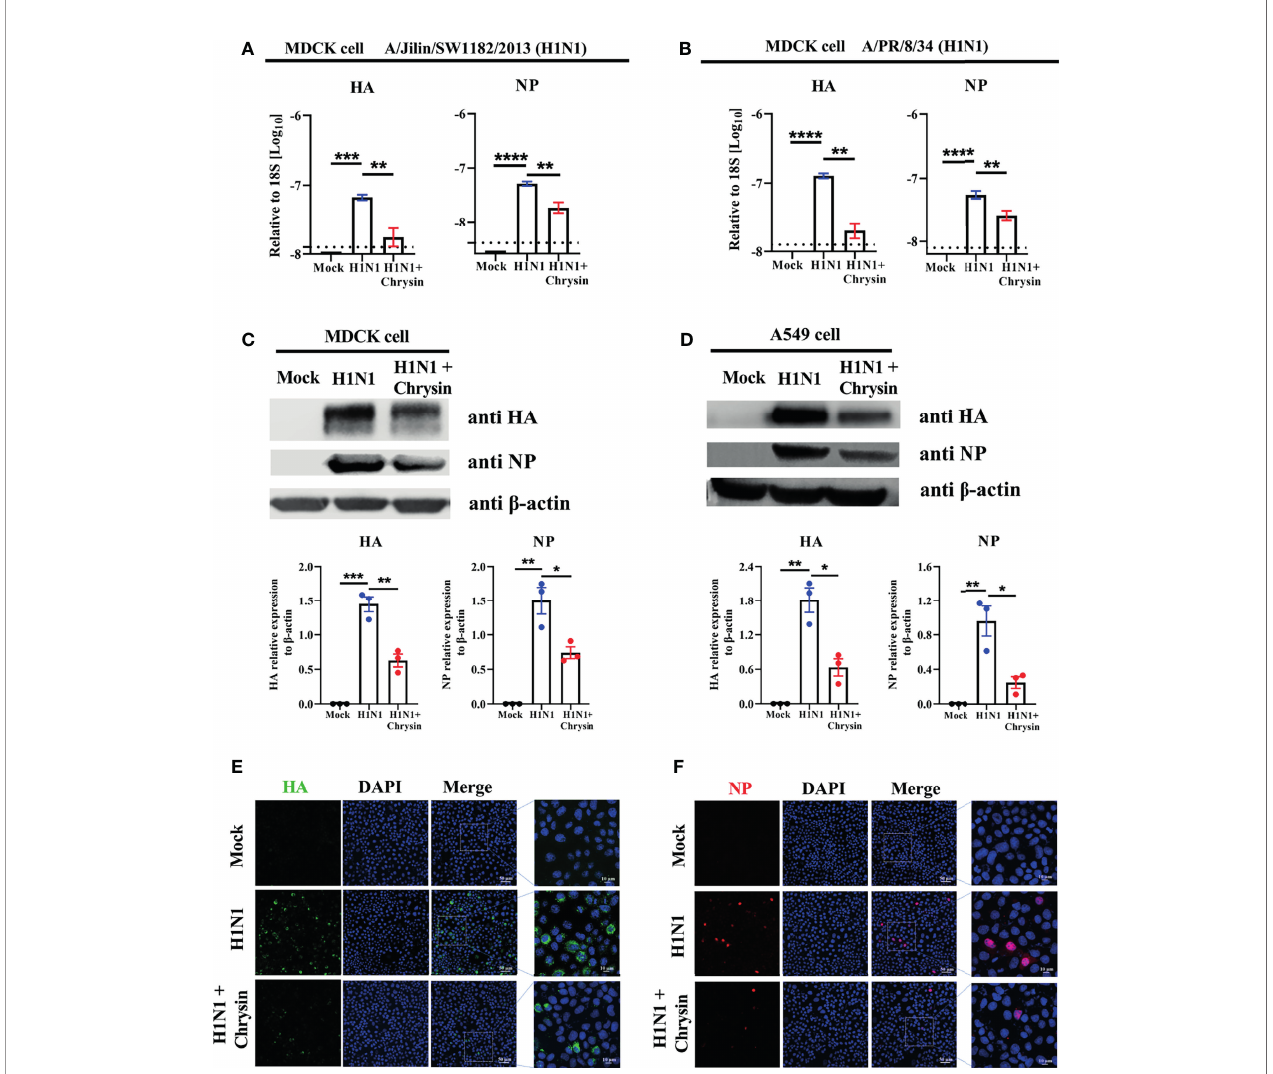
FIGURE 3 | Chrysin suppresses H1N1 in fl uenza virus replication in vitro . (A, B) MDCK cells were infected for 2 hours with A/Jilin/SW1182/2013 (MOI = 0.5) (A) or A/PR/8/34 (MOI = 0.5) (B) viruses with or without 8 m M chrysin, then the viral inoculum was removed and replaced by adding chrysin (8 m M) for 4 hours. HA and NP mRNA levels were determined by RT-qPCR and shown relative to the housekeeping gene 18s with a log value. (C, D) MDCK cells (C) or A549 cells (D) were infected with A/PR/8/34 (H1N1) virus at an MOI of 0.5 in the presence or absence of 8 m M chrysin for 2 hours, following which the cells were treated with chrysin for 4 hours. HA and NP protein levels were detected by western blotting and shown relative to b -actin with a regular value. Dara are expressed as the mean ± SEM. (E, F) MDCK cells were infected with the A/PR/8/34 (H1N1) virus at MOI of 0.5 for 2 hours, then cells were treated with 8 m M chrysin for 4 hours. Representative images of immuno fl uorescence staining in MDCK cells with antibodies against HA [ (E) , green]) and NP [ (F) , red]. The image in the white boxes on the left panels was further enlarged and shown on the right panels. Blue: positive staining of DAPI. All data are representative of three independent experiments, *P < 0.05, **P < 0.01 by unpaired two-tailed Student ’ s t-test. ***P < 0.001, ****P <